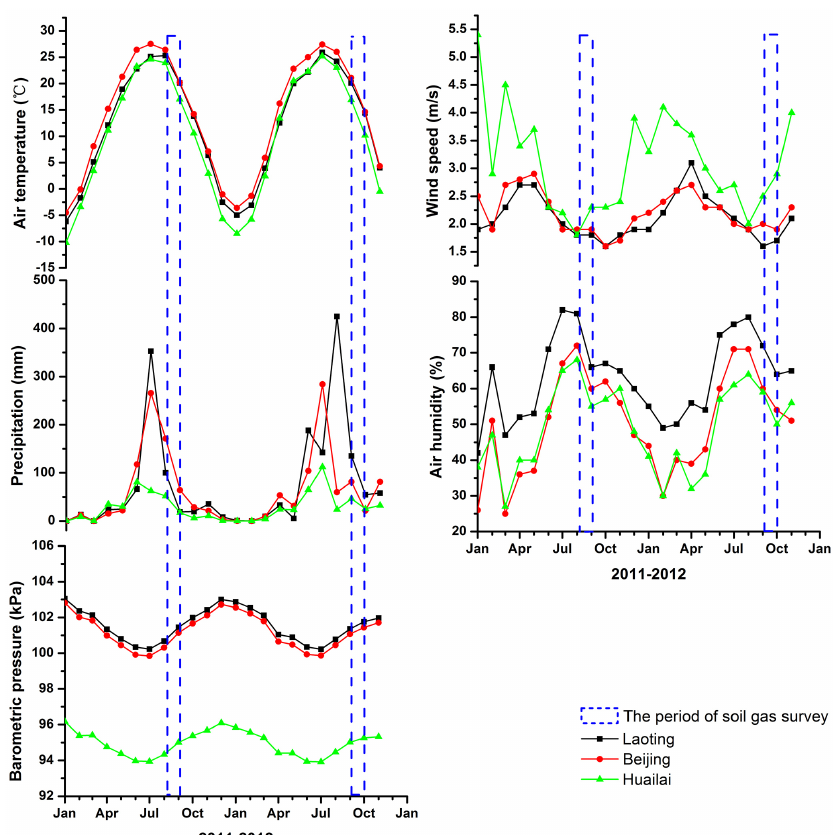
Figure 2. Monthly average values of meteorological parameters in the capital area of China, from January 2011 to November 2012 (China Meteorological Data Sharing Service System, http://cdc.cma.gov.cn/home.do). The black lines represent meteorological parameters in Lao- ting county, Tangshan region; the red lines represent meteorological parameters in Beijing, which is close to the Sanhe–Pinggu region; the green lines represent meteorological parameters in the Huailai area, Yanqing–Huailai Basin; the blue dotted lines represent the period of soil gas